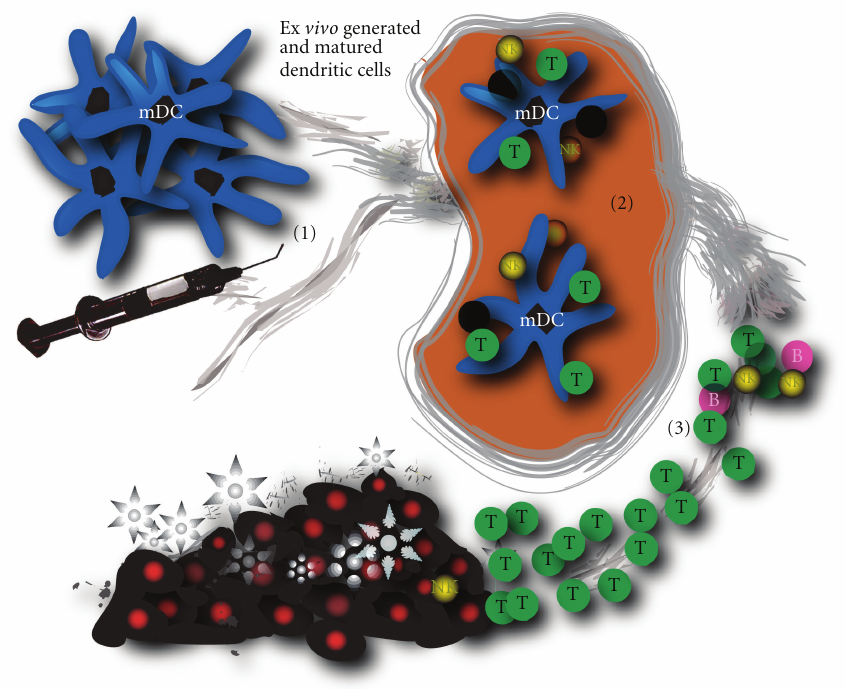
Figure 2: Schematic drawing showing the administration of ex vivo cultured mature dendritic cells into a patient (1), resulting in antigen presentation in the lymph node (2) and a specific antitumour cytotoxic antitumour response (3). Tumour cells are depicted as dark